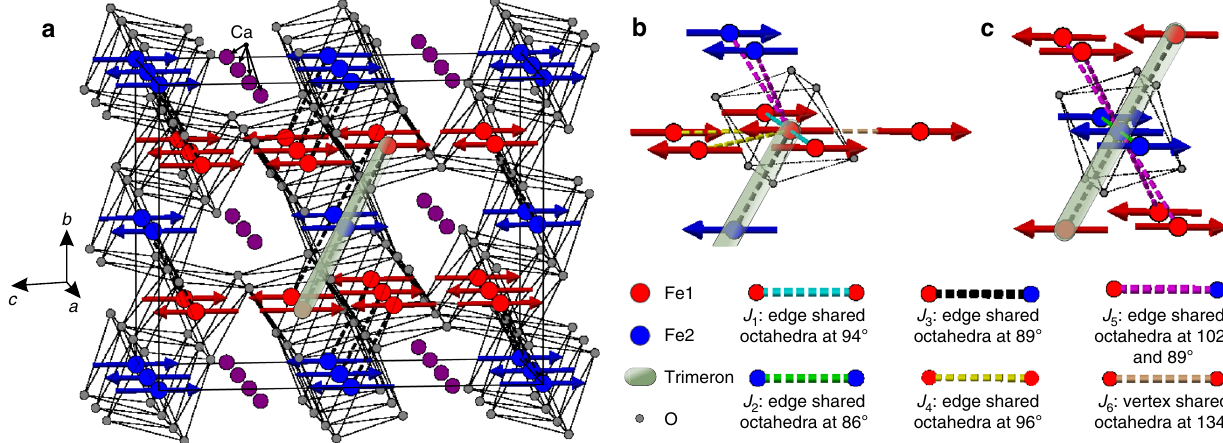
Fig. 5 Magnetic ground state and main exchange interactions of charge ordered CaFe 3 O 5 . a Magnetic structure of charge-ordered CaFe 3 O 5 between 280 and 5 K with the magnetic unit cell denoted by the black box and the trimerons shown with black dashed lines (which also denote the J 3 interactions) between Fe centres, with one of them further highlighted by the shaded ellipse. b Coupling interactions experienced by Fe1 to other Fe sites. c Coupling interactions experienced by Fe2 to other Fe sites. The type of coupling interaction is denoted by the colour of the bond as shown in the